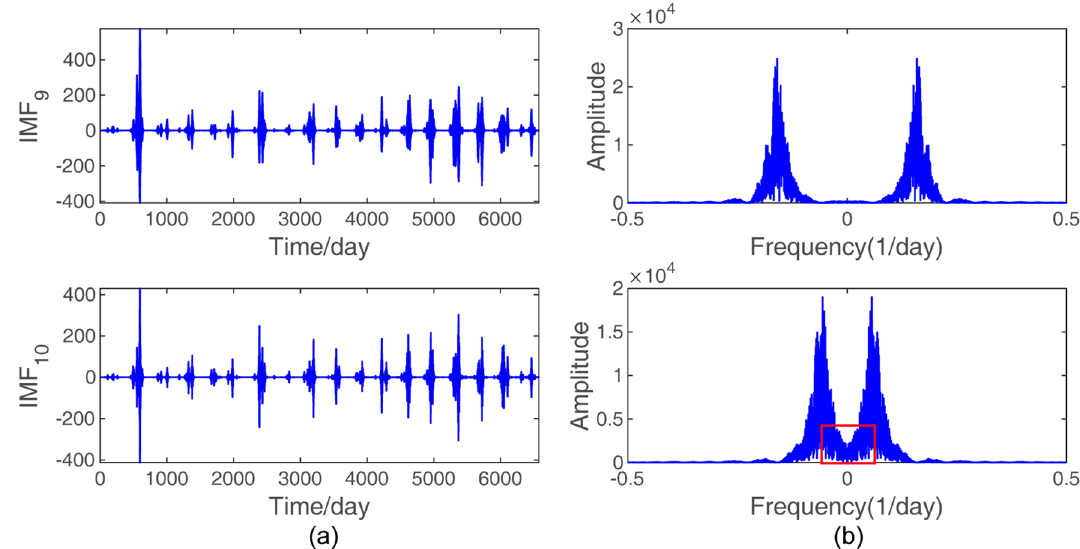
Figure 6. Schematic diagram of the center frequency aliasing of the last IMF: ( a ) the last two sequence waveforms and ( b ) the frequency spectrum representations. The area surrounded by the red rectangular border indicates the aliasing.